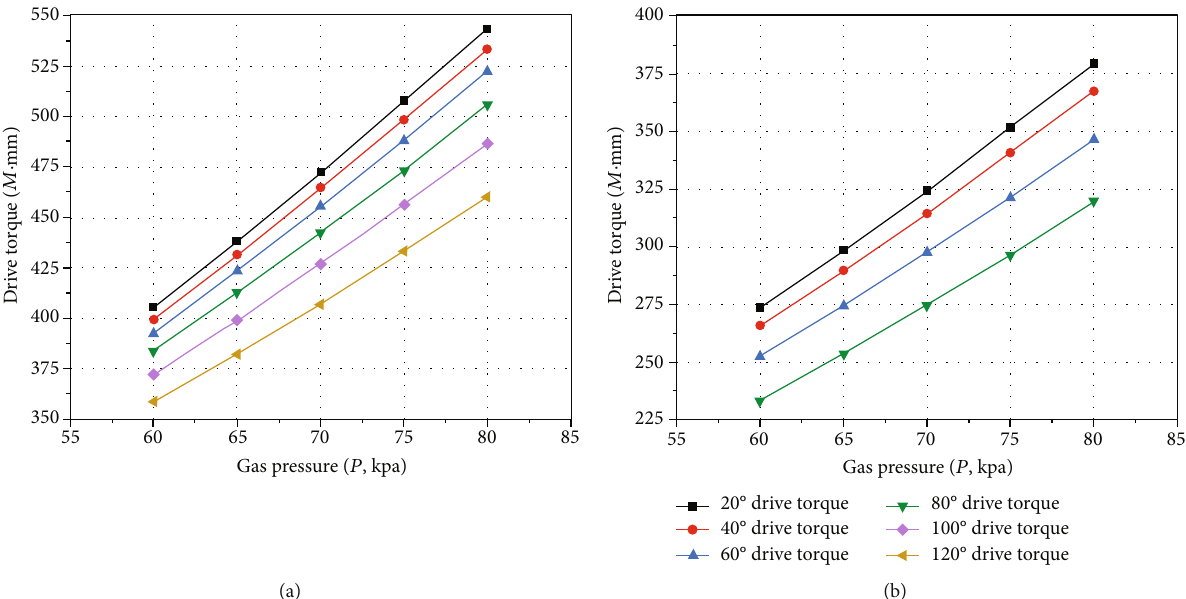
Figure 18: The P − M characteristic curves of pneumatic soft-bodied bionic actuator for fi xed angle. (a) Middle part driving torque. (b) Left and right side driving